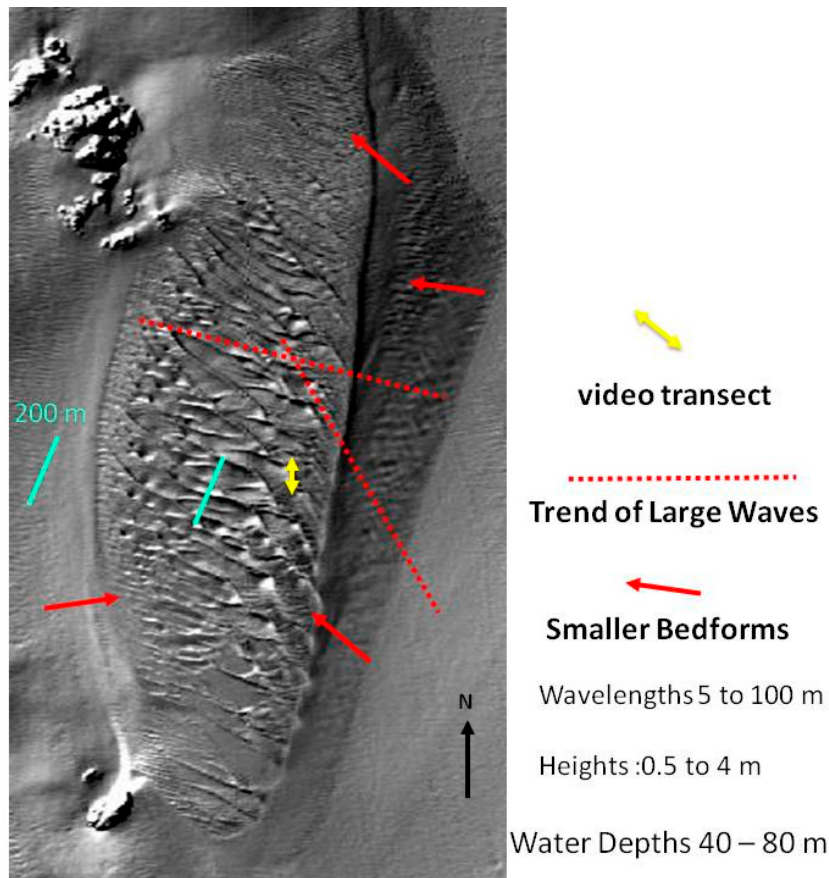
Figure 7. MBES image of the San Juan Channel sand wave field that shows two different sizes of sediment waves from long high amplitude to short low-amplitude waves. Red solid arrows show where ripples and small amplitude sediment waves exist along the edges of the field, dashed red lines show orientation of large sand waves, yellow line with arrows shows video camera transect made to validate sediment type and morphology, and green lines are scale marks used to show wave lengths.